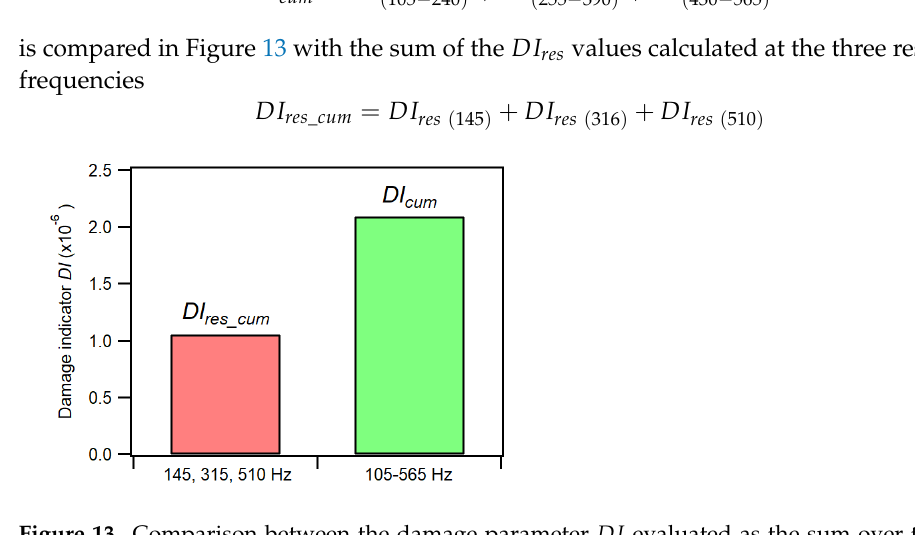
Figure 12. Comparison between the damage parameter DI evaluated at a resonance frequency (red bar) and that evaluated as the sum over the eight sub-ranges of the examined pump frequency spans (green bar).